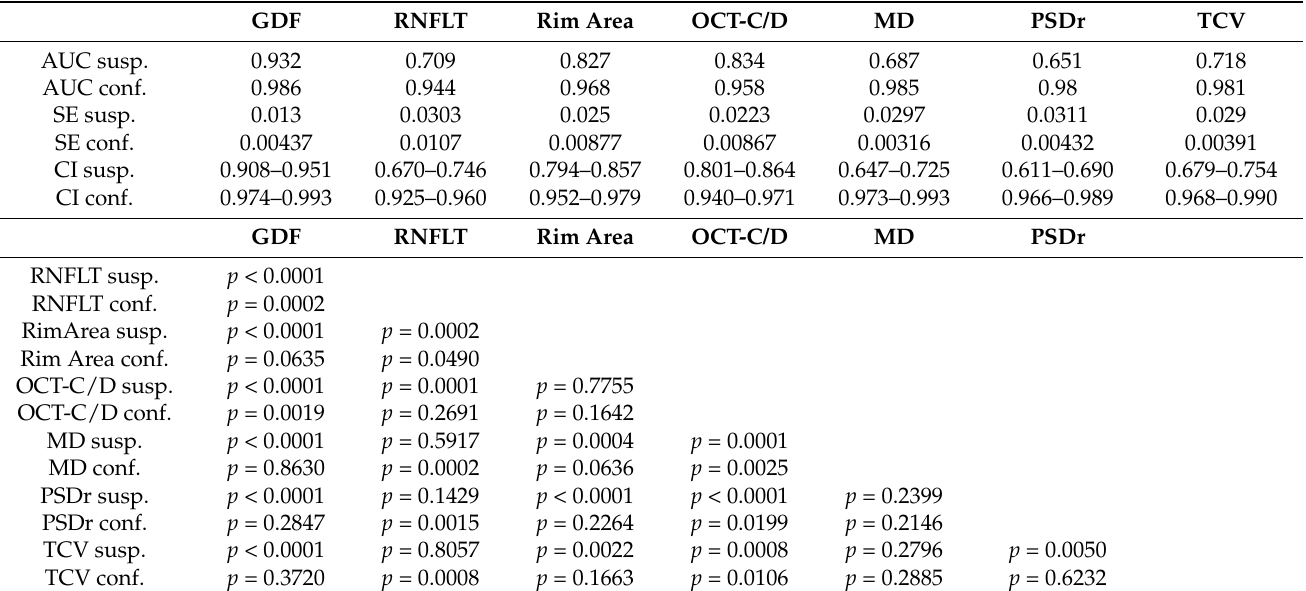
Table 3. Performance of Laguna ONhE, OCT, and perimetry indices.